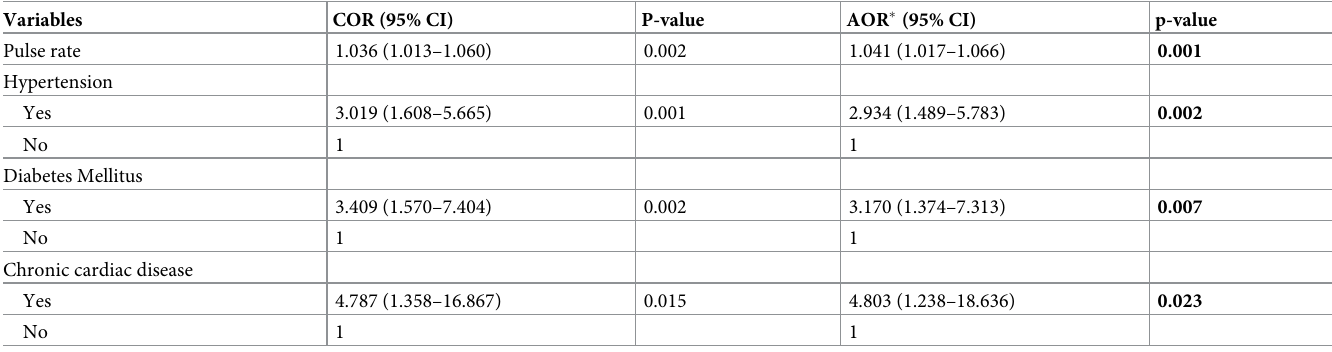
Table 6. Determinants of disease